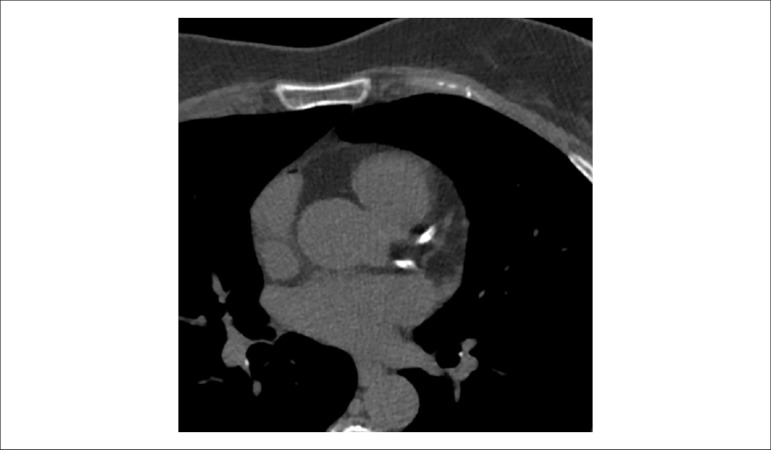
Case 5 - Angio-CT revealing severe calcification in coronary arteries.